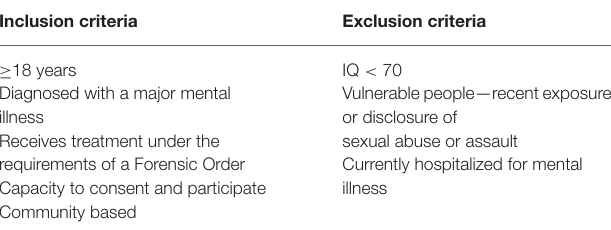
TABLE 1 | Inclusion and exclusion